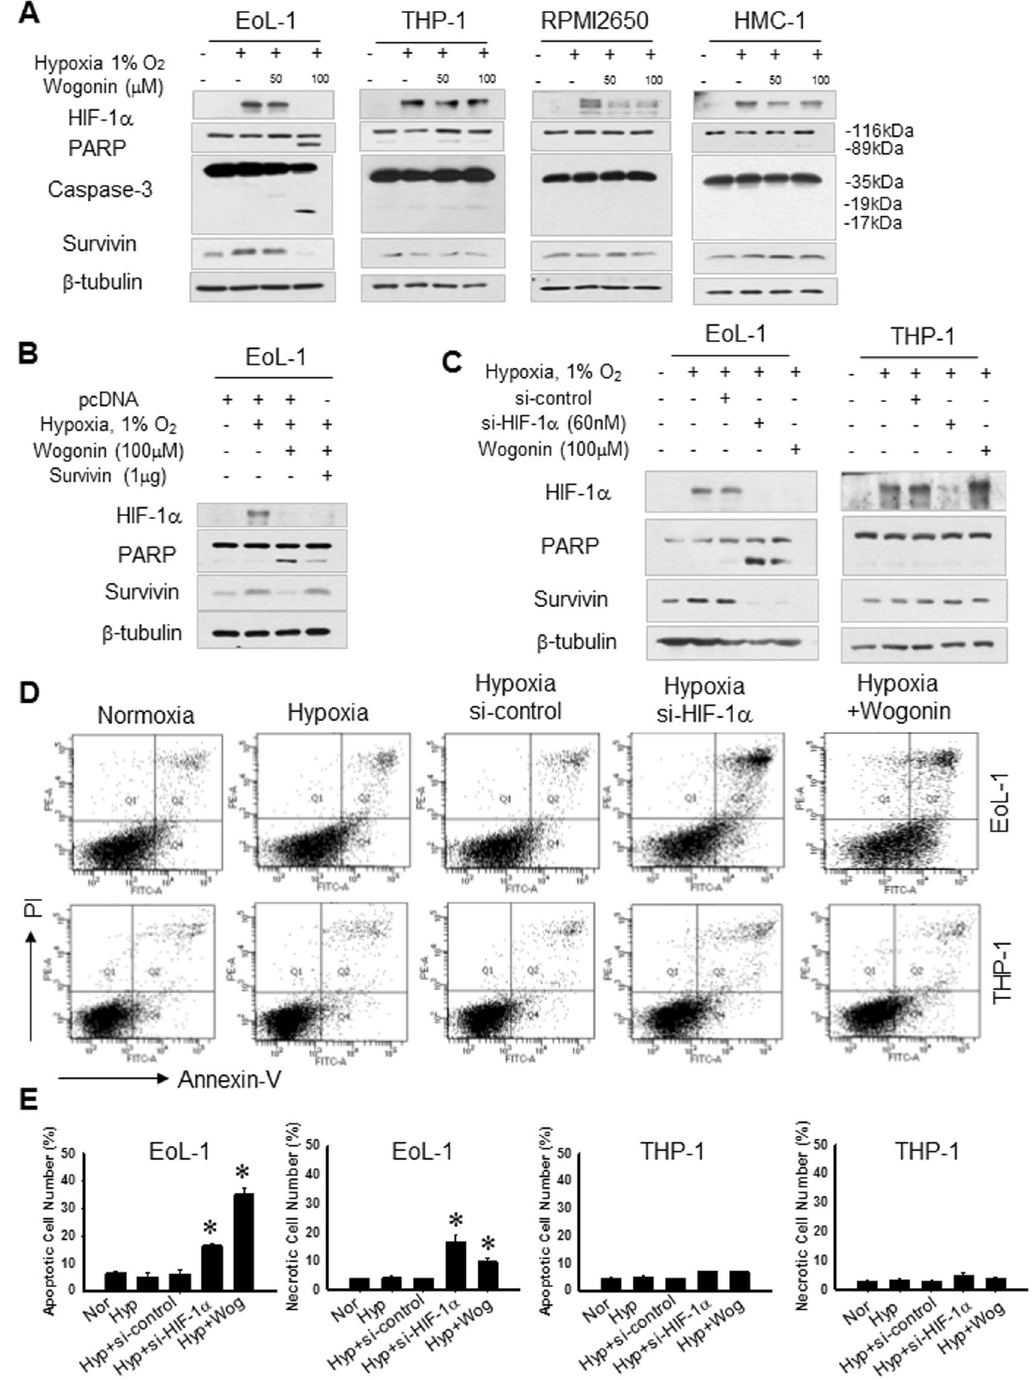
Figure 3. Inhibition of HIF-1 α down-regulates survivin expression in EoL-1 cells. ( A ) Cells were treated with wogonin and incubated under normoxic or hypoxic conditions for 4 hours. HIF-1 α , PARP, caspase-3 and survivin protein expression was detected. Survivin expression was up-regulated in EoL-1 cells under hypoxia. Wogonin decreases HIF-1 α and down-regulates survivin expression in EoL-1 cells. ( B ) Survivin overexpression in EoL-1 cells delays cell apoptosis after wogonin treatment ( C ) EoL-1 and THP-1 cells transfected with 60 nM HIF-1 α siRNA (si-HIF1 α ) or scrambled siRNA (Si-Cont) were incubated under normoxia or hypoxia for 8 hours. Cells were treated with 100 μ M wogonin in hypoxic conditions. Cell lysates were prepared for immunoblotting with the indicated antibodies. ( D , E ) EoL-1 and THP-1 cells stained with annexin-V and propidium iodide were subjected to flow cytometry. Cells were treated with 100 μ M